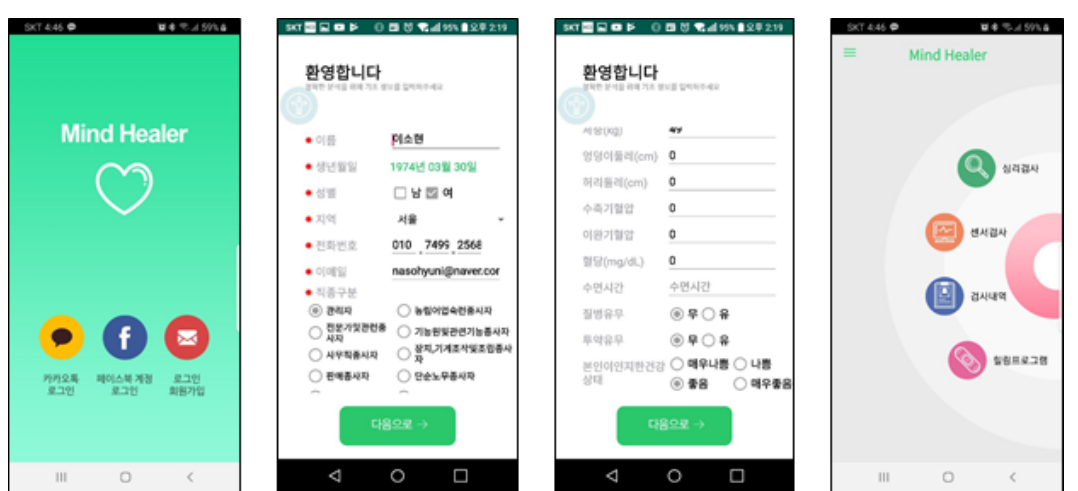
Figure 2. Basic composition of the Mind Healer App. Login screen/Input page of Personal information/Input page of perceived health status/Psychological test and sensor test page.